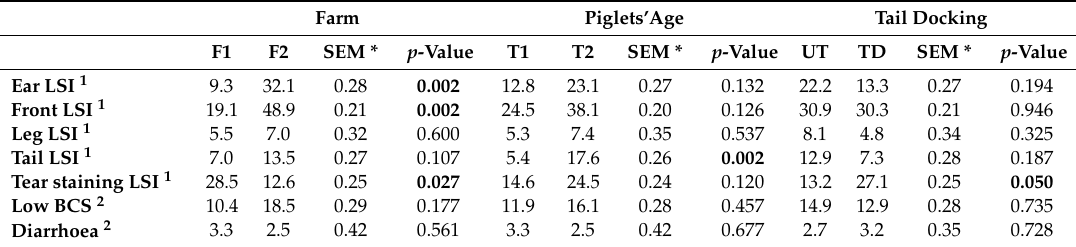
Table 4. E ff ect of the farm, piglets’ age and tail docking on lesions and health parameters. The numbers are estimate least-square means of the